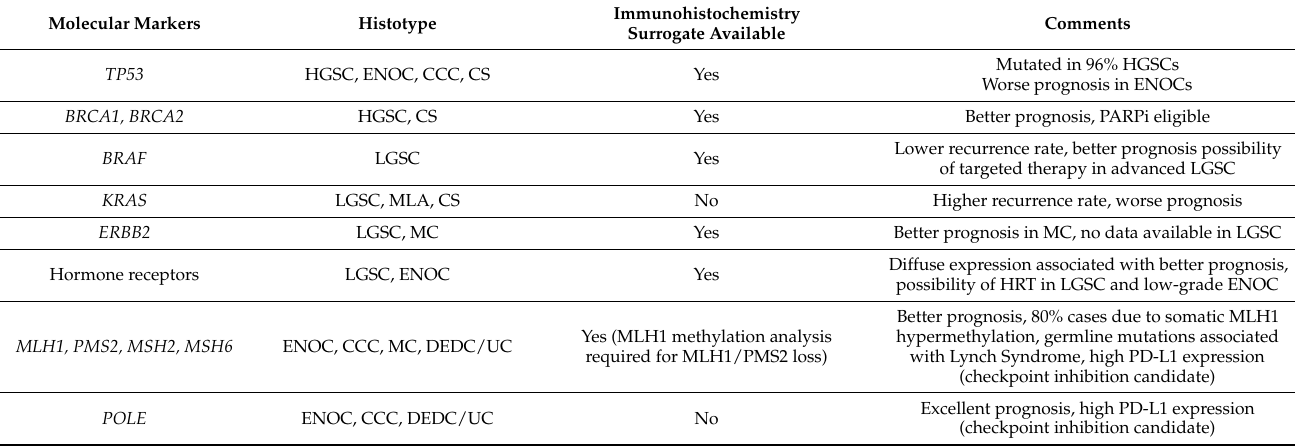
HGSC: high-grade serous carcinoma; LGSC: low-grade serous carcinoma; ENOC: endometrioid ovarian carcinoma; CCC: clear cell carcinoma; MC: mucinous carcinoma; MLA: mesonephric-like adenocarcinoma; DEDC/UC: dedifferentiated/undifferentiated carcinoma; CS: carcinosarcoma; HRT: hormonal replacement